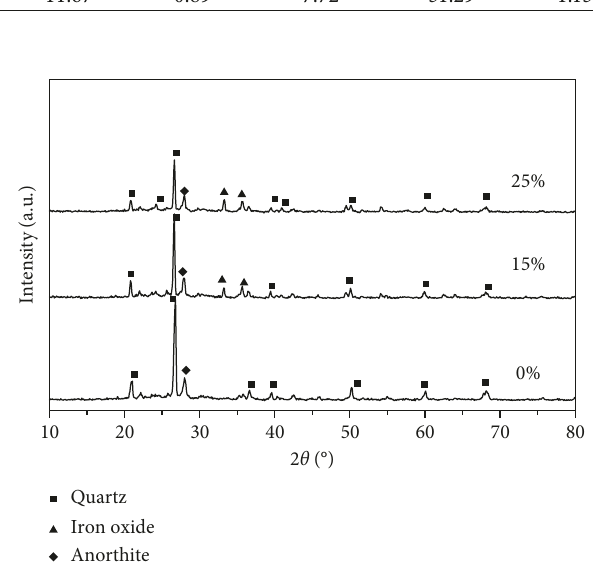
Figure 1: XRD spectra of ceramics with different amounts of vanadium and titanium industrial slags at sintering temperature of 1100 °